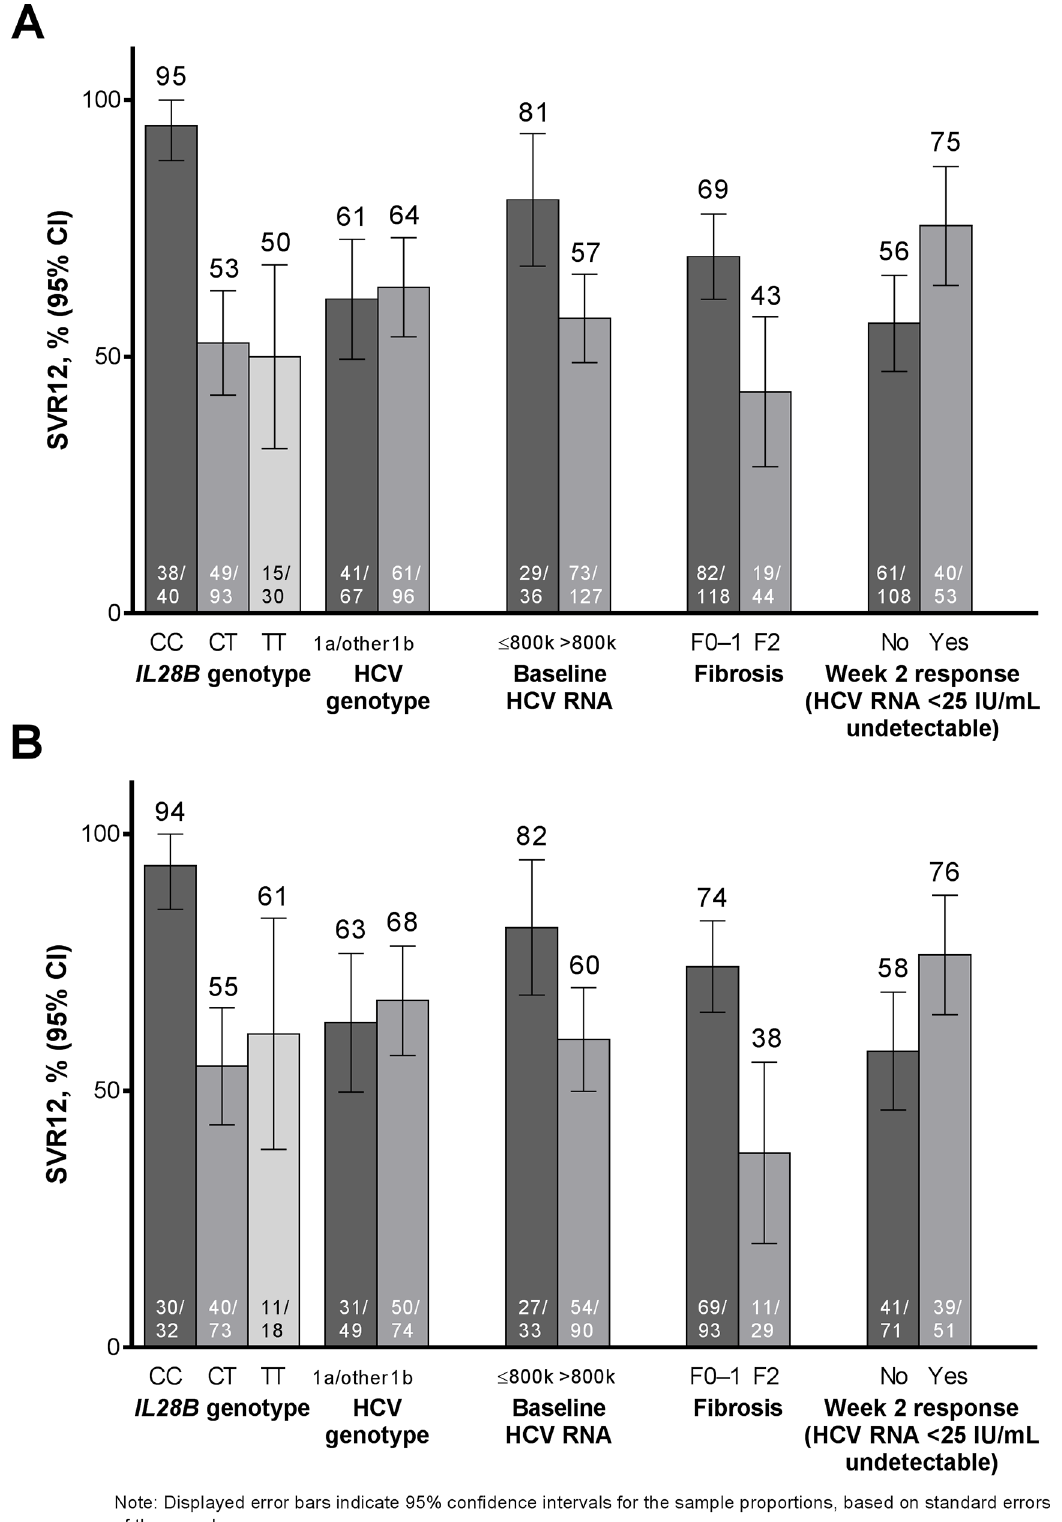
Fig 3. Percentage of [A] all patients, and [B] patients receiving 12 weeks of treatment who achieved SVR12, according to baseline characteristics and on-treatment factors. doi:10.1371/journal.pone.0158526.g003 PLOS ONE | DOI:10.1371/journal.pone.0158526 July 18,